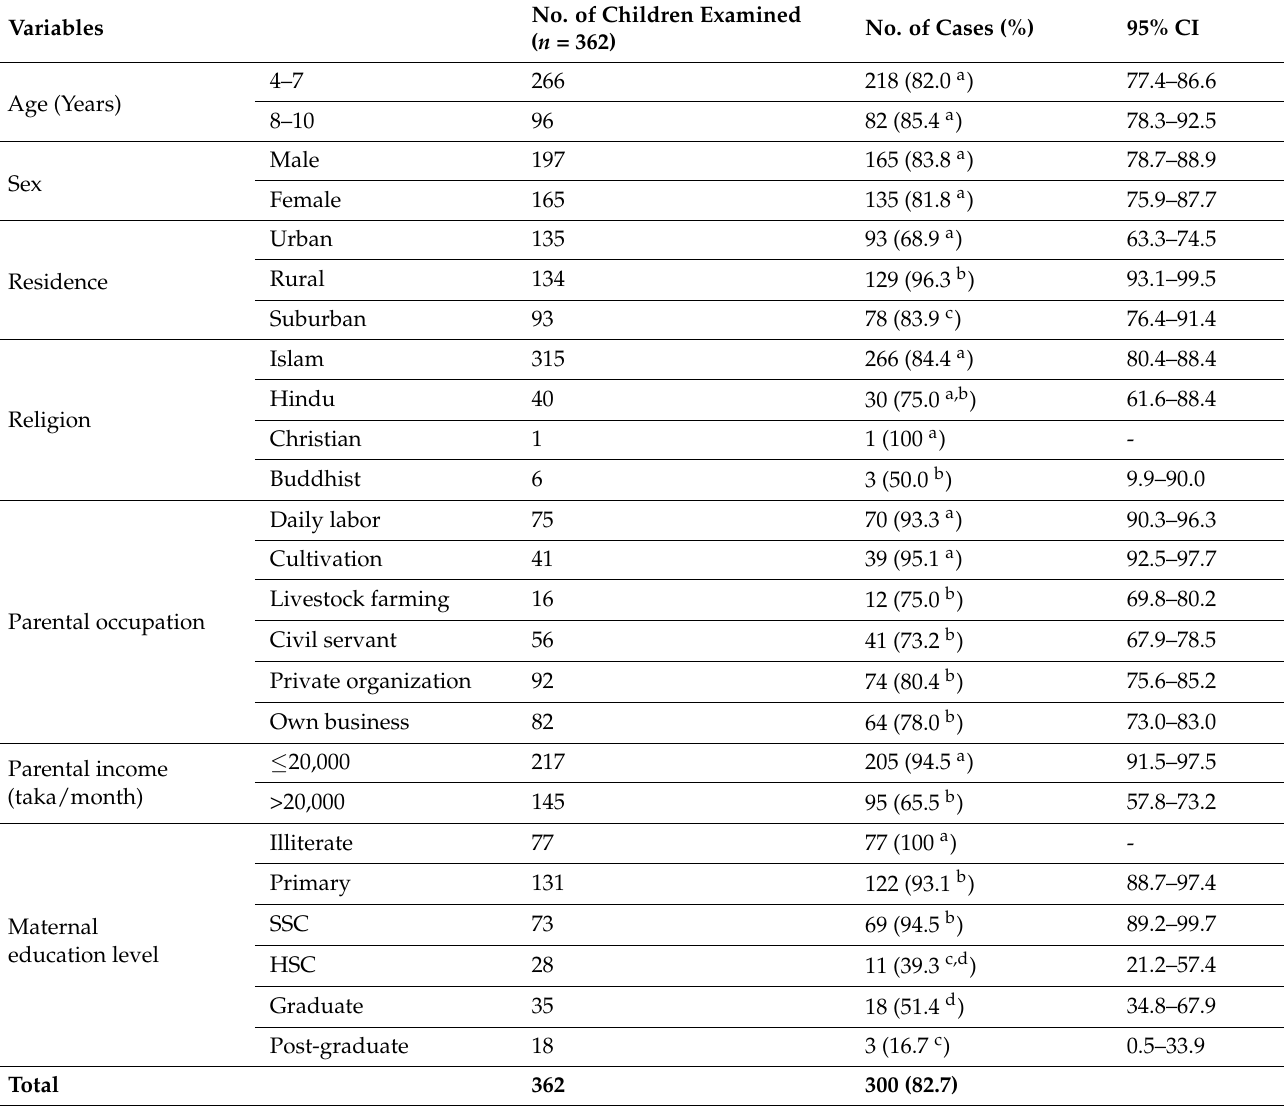
Table 1. Prevalence of dental caries in relation to sociodemographic characteristics.